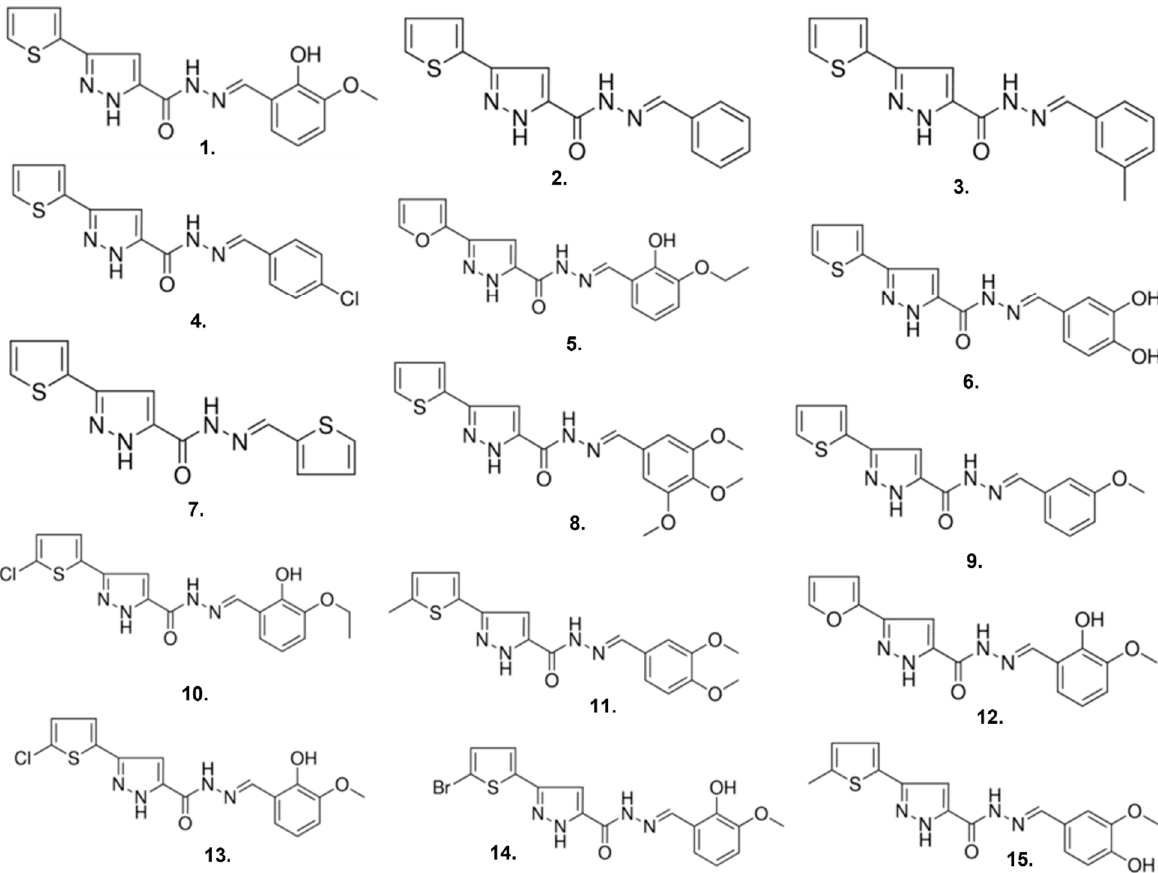
Figure 4. Chemical structures of compound 1 and 14 analogs of compound 1 .